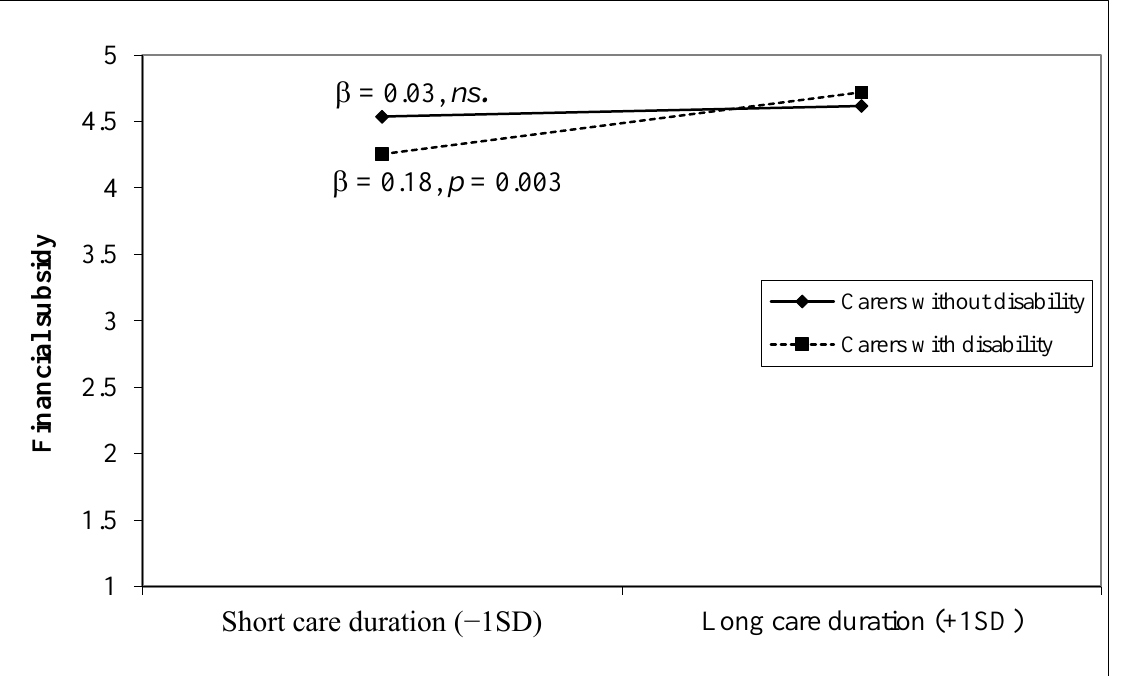
Figure 2. Relationships between care duration and perception of the importance of service improve- ment among carers on caregiver assistances.